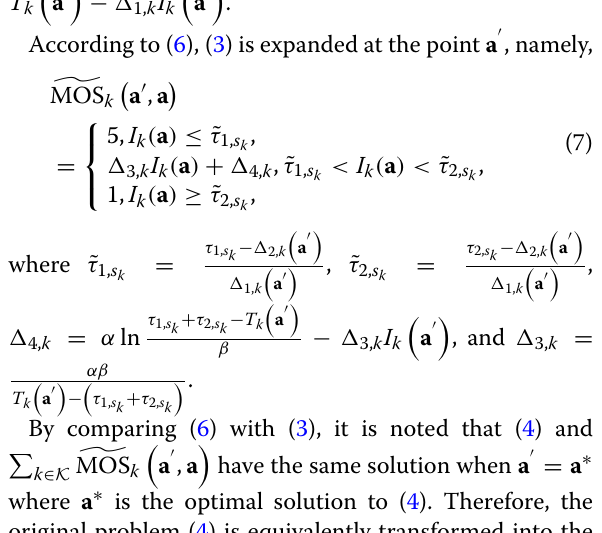
Fig. 2 The QoE metric